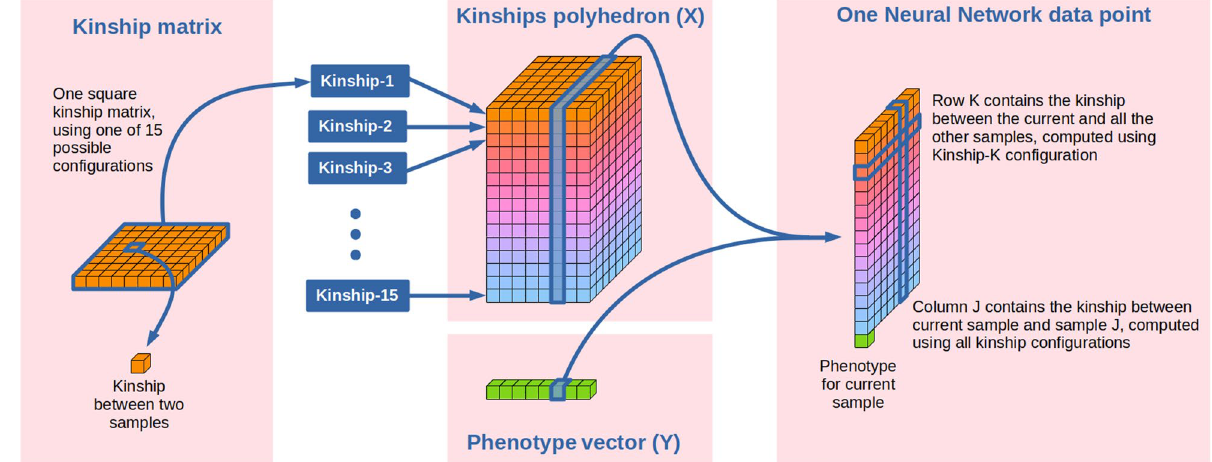
Figure 2. Relationship between continuous phenotypes and SNP genotype data as modeled in this study. SNP genotypes were used to build 15 kinship matrices based on mixture of additive, dominance and epistasis effects. The matrices were then ordered by pairwise similarities and stacked together in a ( n × n × 15 ) 3D polyhedron. For each sample one phenotypic value was paired to one ( 15 × n ) 2D slice of data and fed to the